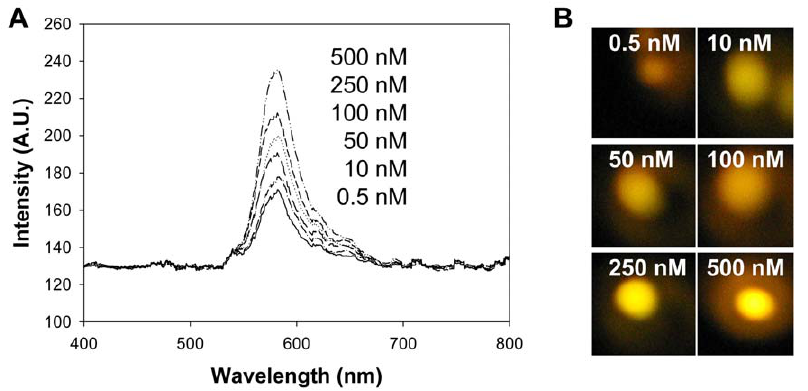
Figure 3. Detection of various concentrations of a synthetic oriC oligonucleotide by MAMEF. (A) The graph shows the increase in intensity as the concentration of oligonucleotide increases. (B) The actual fluorescent signal produced at each concentration. Excitation=532 nm,